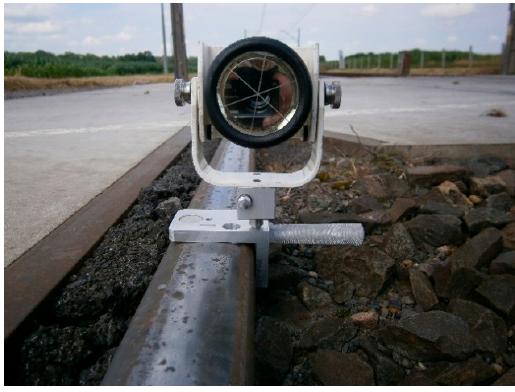
Figure 5. Geodetic standard prism (round) integrated with MMS.